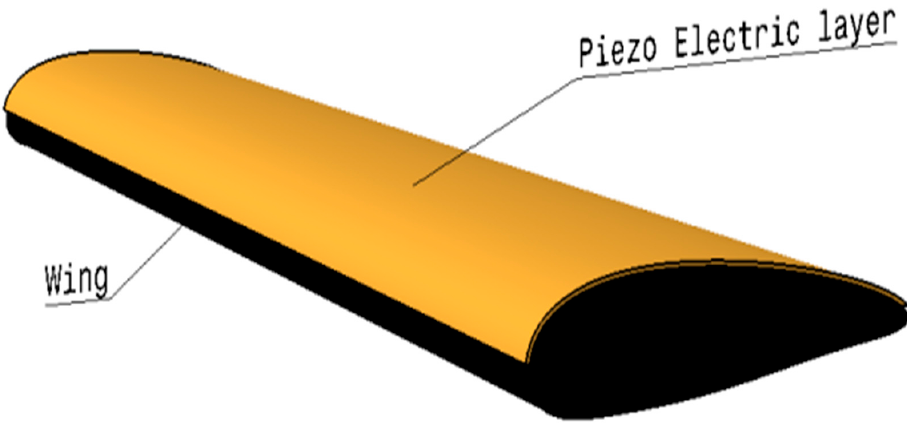
Figure 29. A typical view of an airplane wing with piezoelectric patches.